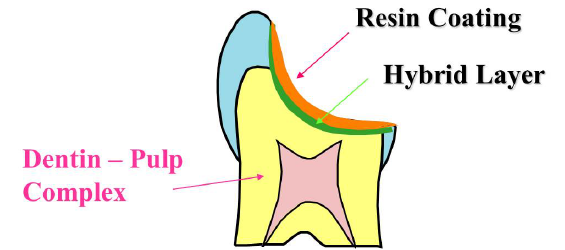
Figure 6. The resin coating technique produces a hybrid layer and tight sealing film on the dentin surface and protect dentin-pulp